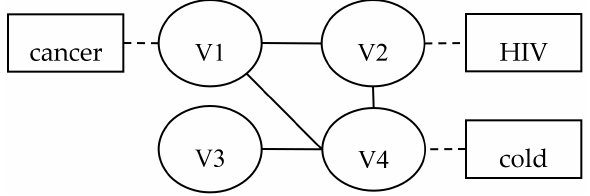
Figure 1. An example of attribute distribution: human disease network.